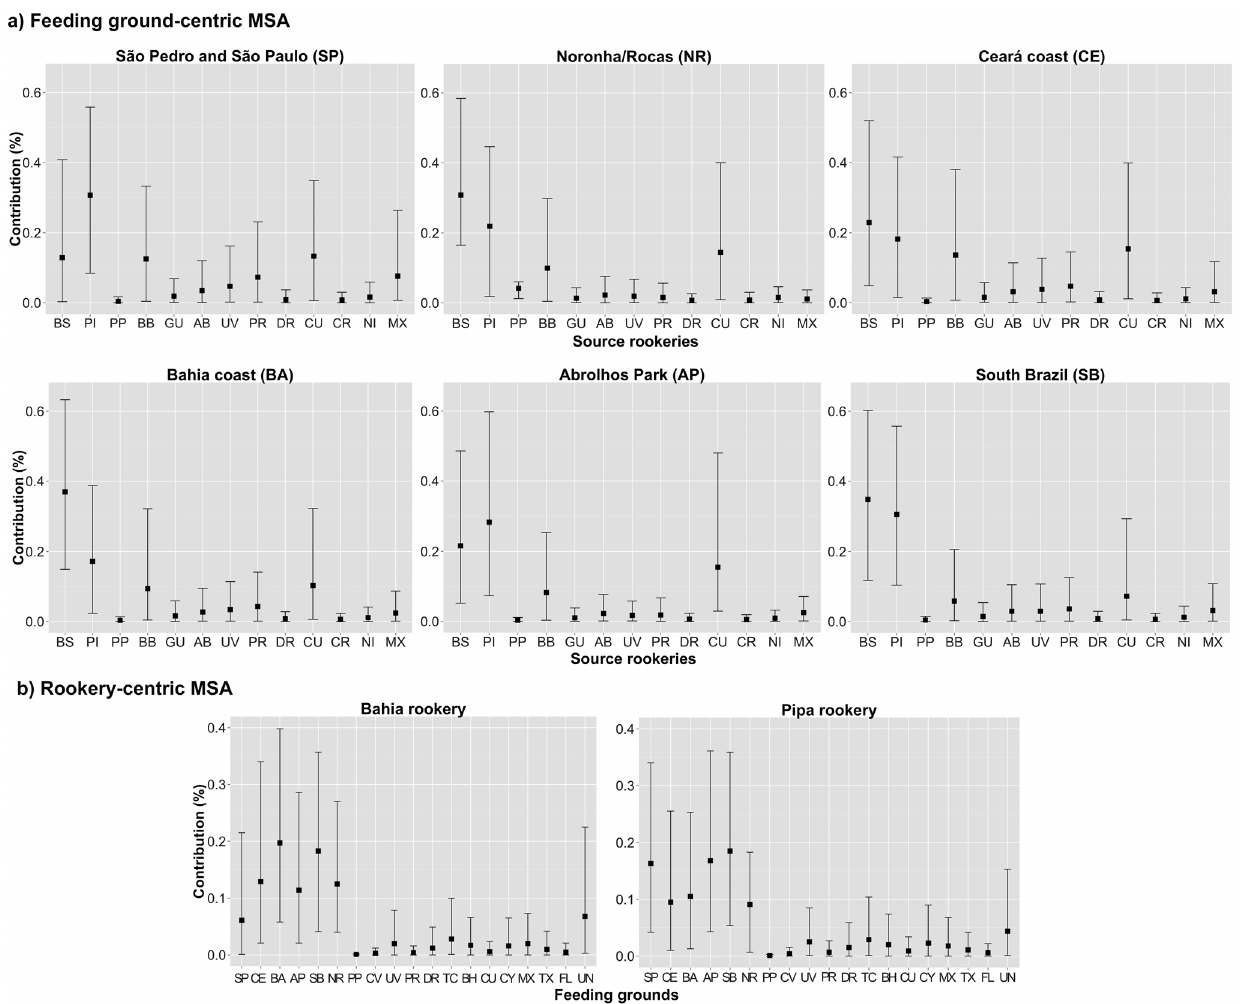
Figure 3. Many-to-many mixed stock analysis estimates for Brazilian populations. (a) shows feeding ground-centric estimates, and (b) rookery-centric estimates. MSA outputs for all other areas are shown in Figures S1 and S2. BS= Bahia/Sergipe, PI= Pipa, PP= Principe, BB= Barbados, GU= Guadeloupe, AB= Antigua & Barbuda, UV= U.S. Virgin Islands, PR= Puerto Rico, DR= Dominican Republic, CR= Costa Rica, NI= Nicaragua, CU= Cuba, MX= Mexico, SP= Sa˜o Pedro and Sa˜o Paulo, CE= Ceara´ coast, BA= Bahia coast, AP= Abrolhos Park, SB= South Brazil, NR= Noronha/Rocas, PP= Principe, CV= Cape Verde, TC= Turks & Caicos, BH= Bahamas, FL= Florida, CY= Cayman Islands, TX= Texas, FL= Florida, UN=